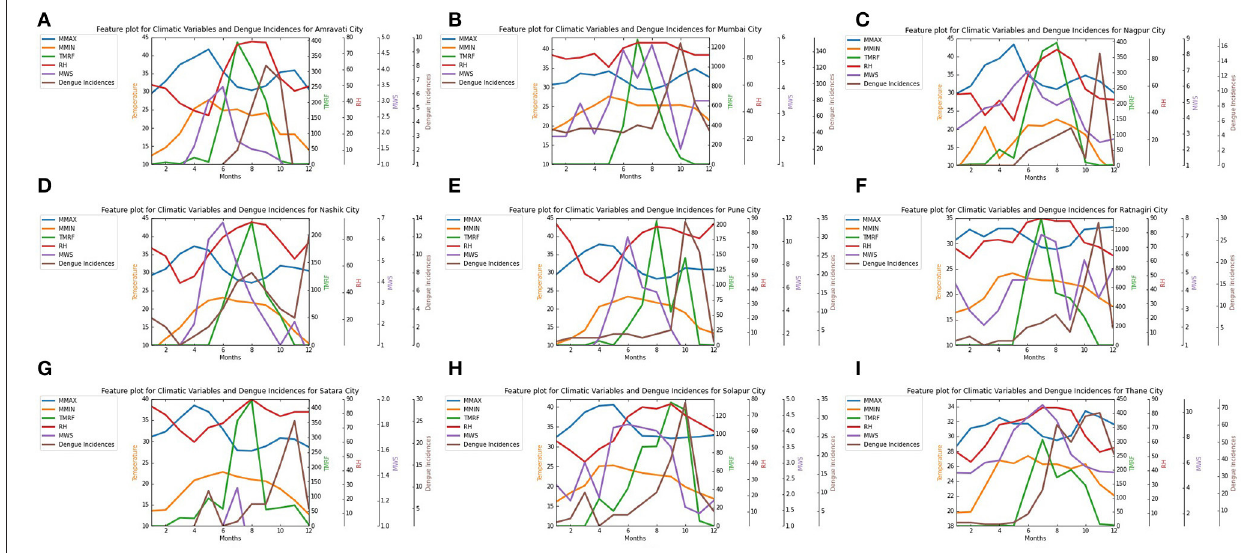
FIGURE 5 | City Wise Features Plot for climate variables monthly mean minimum temperature, mean maximum temperature, Average rainfall, Relative humidity, Mean wind speed, and monthly dengue incidences for nine selected cities in Maharashtra from 2009 to 2019. (A) Amravati, (B) Mumbai, (C) Nagpur, (D) Nashik, (E) Pune, (F) Ratnagiri, (G) Satara, (H) Solapur, (I)